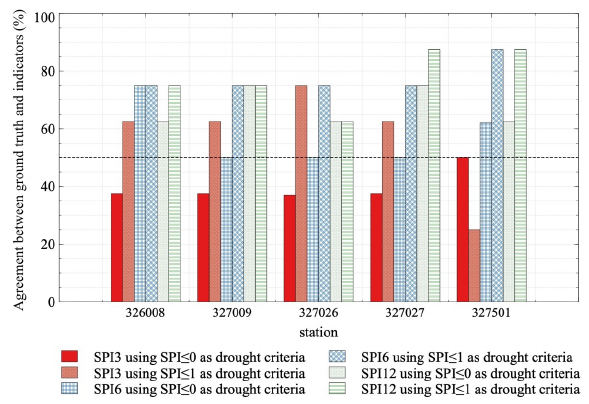
Fig. 5. Agreement between ground truth and drought indicators using SPI < 0 and SPI ≤ 1 as drought criteria.